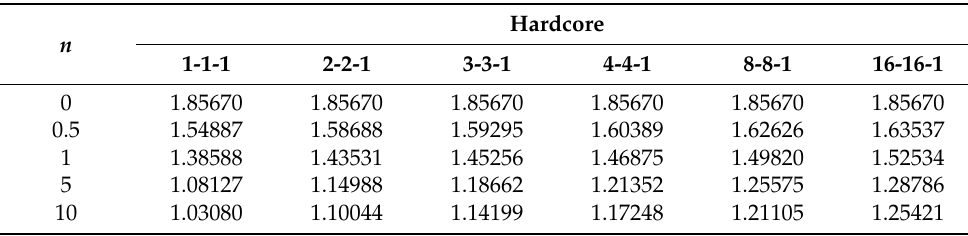
Table 6. The facesheet limits of the calibrated fundamental frequencies, ω , for simply supported square FG sandwich plates with homogeneous hardcore s( b / h = 10